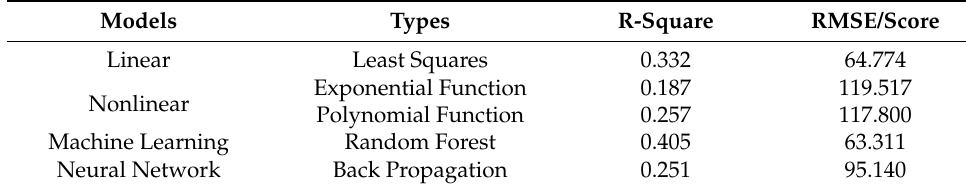
Table 4. Ability of all models to directly predict SBE